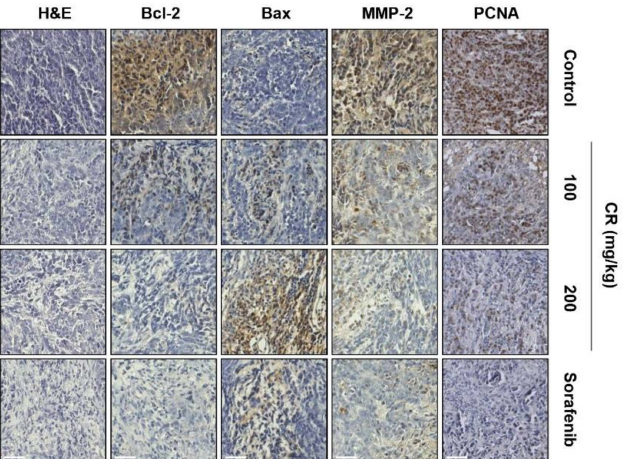
Figure 6. Immunohistology in Hep3B xenograft tumor sections in orally administration of CR. Tumor tissues were collected and fixed in 4% formaldehyde and embedded in paraffin blocks. Sections of 5 µ m thickness were cut by microtome. Hematoxylin and eosin (H&E), Bcl-2, Bax, matrix metalloproteinase (MMP)-2, and proliferating cell nuclear antigen (PCNA) staining of tumor sections isolated from mice administered different treatments or controls. Scale bars; 40 µ m.